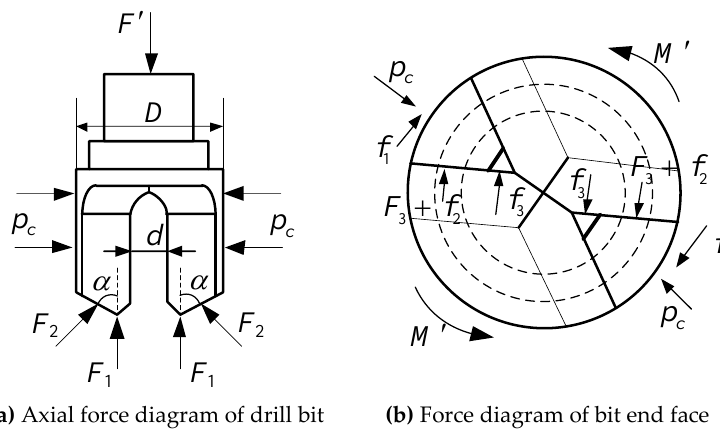
Figure 3. The force state diagram of the cutting surface of a bit.